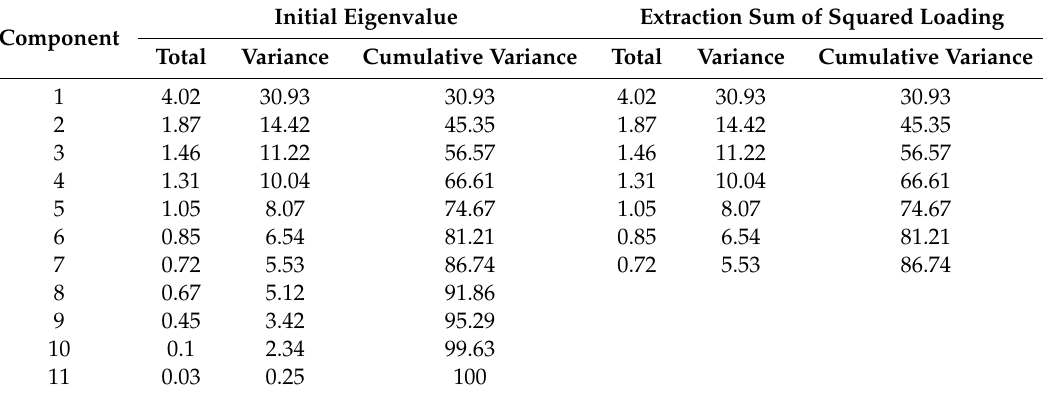
Table 1. Variance contribution-rate ranking of components (note: units of the variance contribution rate and the cumulative variance contribution rate are %).